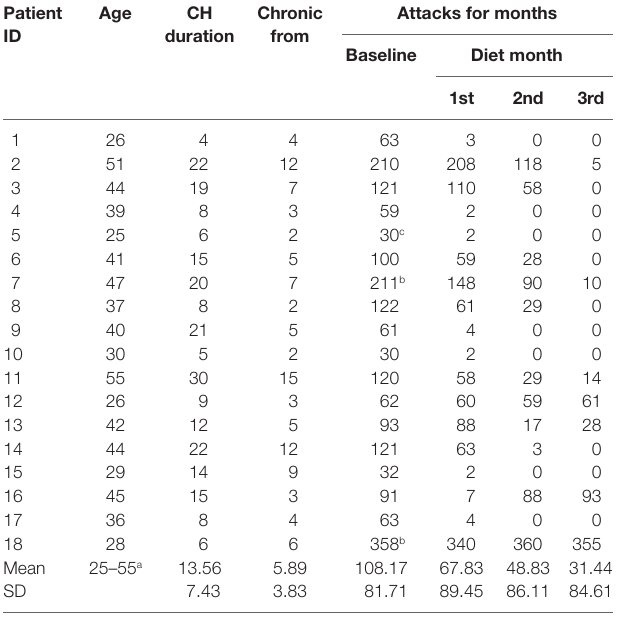
Table 1 | Sociodemographic and clinical characteristics of 18 chronic cluster headache (CH)